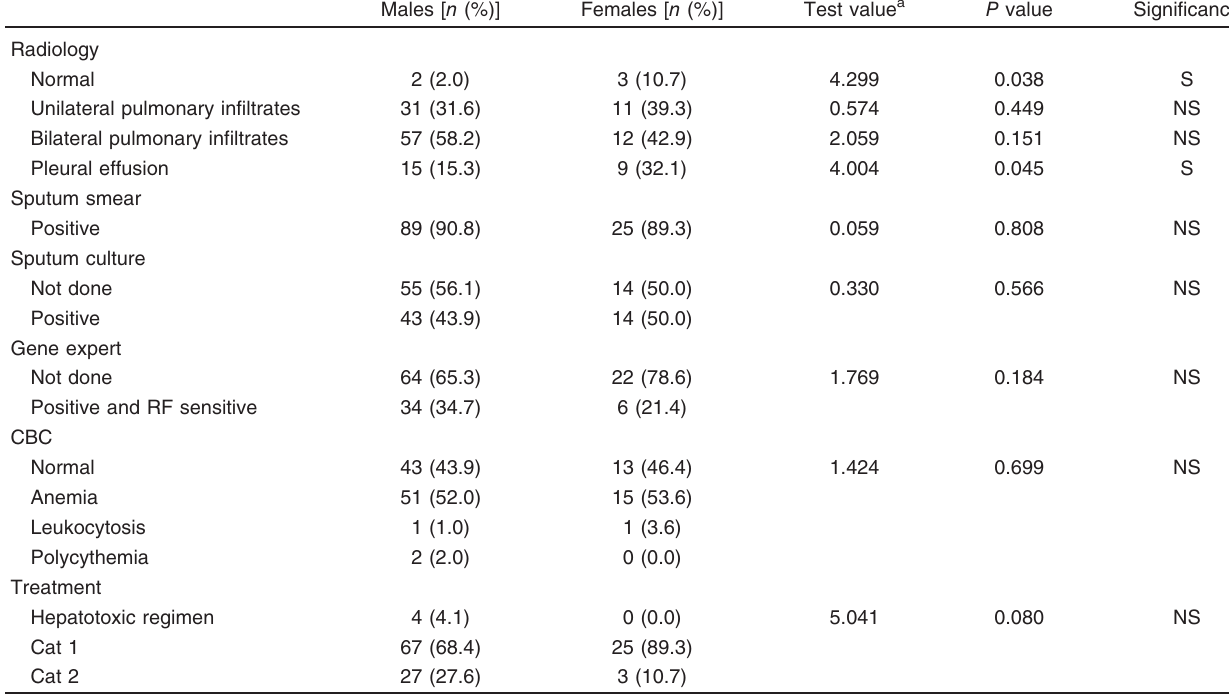
Table 5 Comparison of the workup and treatment regimen between females and males Males [ n (%)]